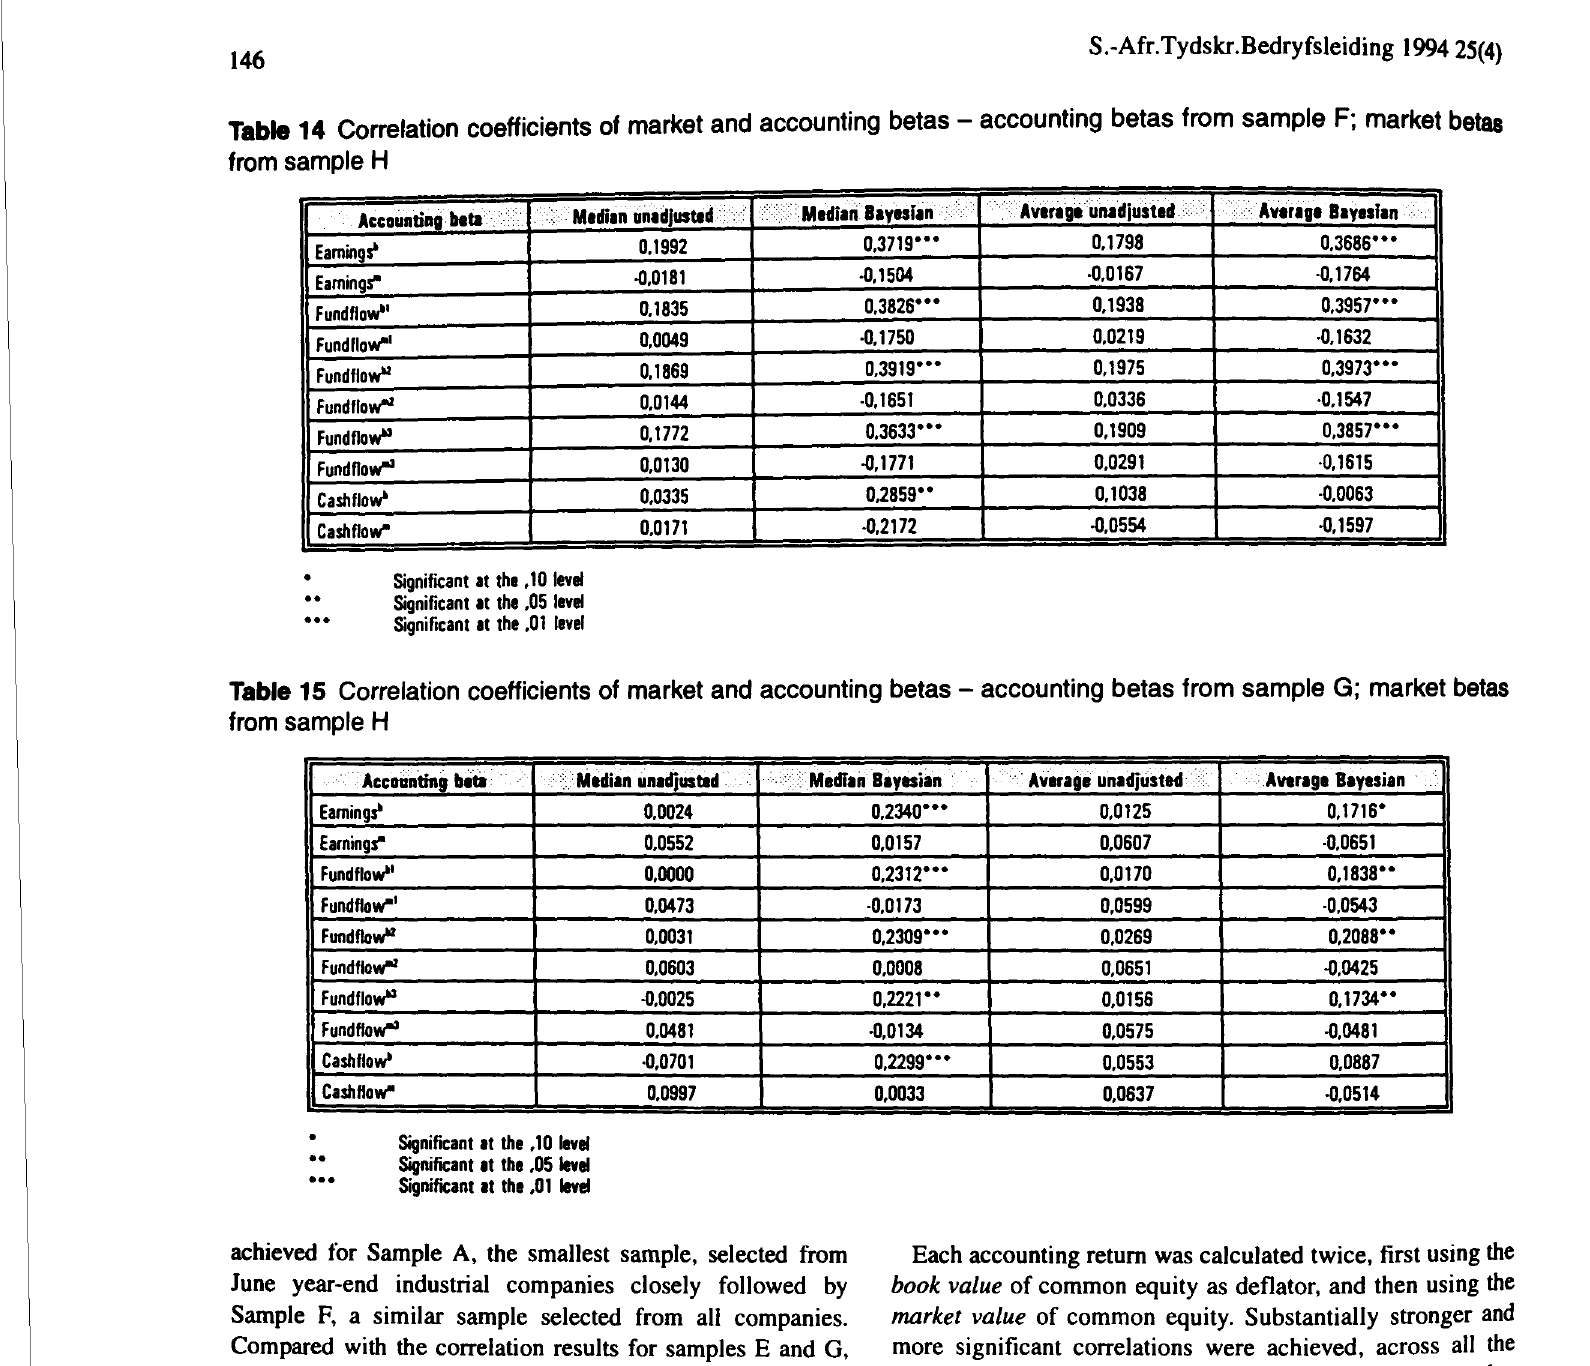
Table 14 Correlation coefficients of market and accounting betas - accounting betas from sample F; market betas from sample H